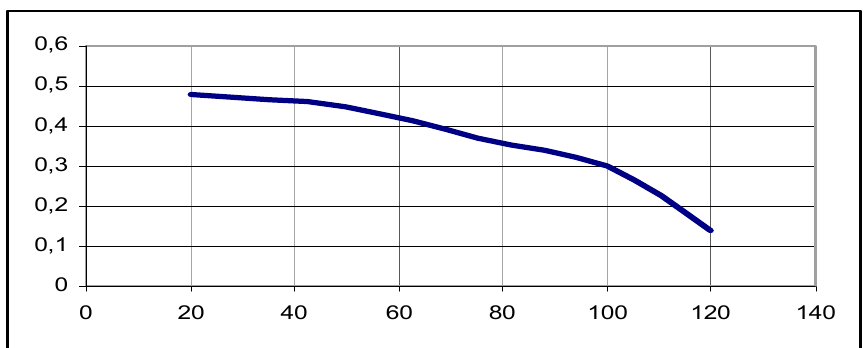
Figure 4. Dependence of the standardized a posteriori dispersion δ D2 on the number of measured pulses received in the transition process.